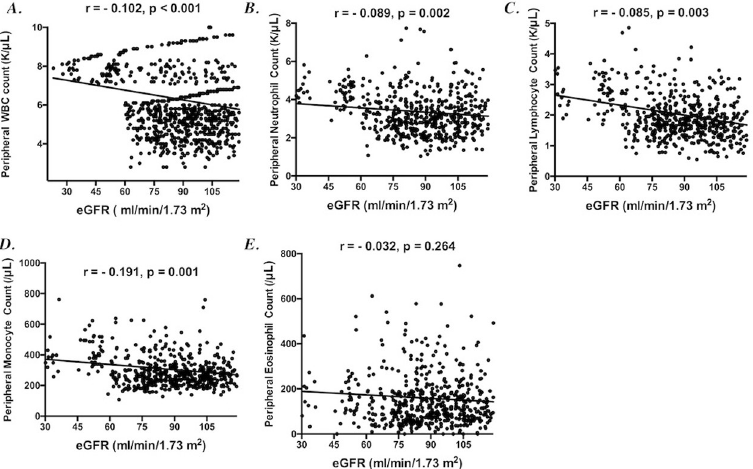
Fig 1. The correlation between renal function (presented by estimated glomerular filtration rate) and peripheral total and differential leukocyte count in the study